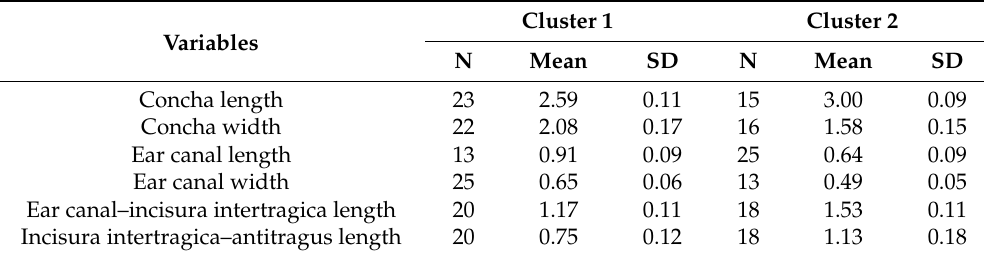
Table 7. Results of clustering ear